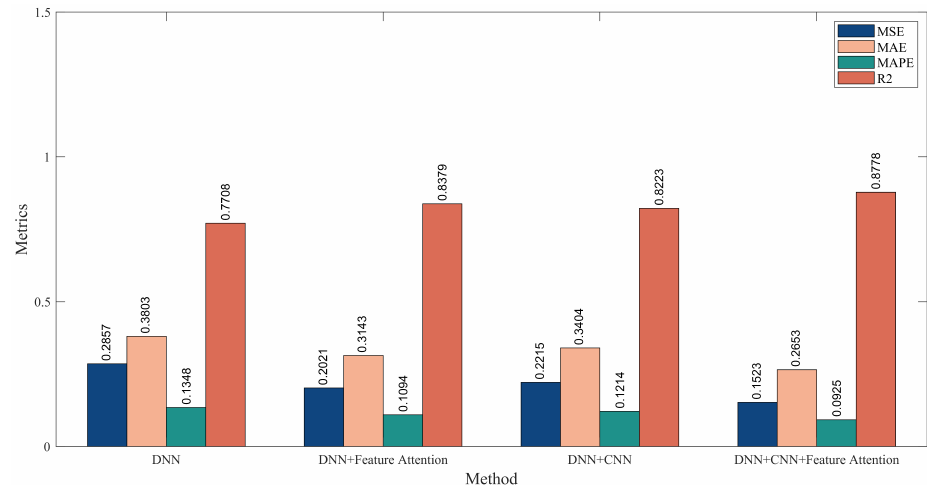
Figure 16. Feature Attention performance